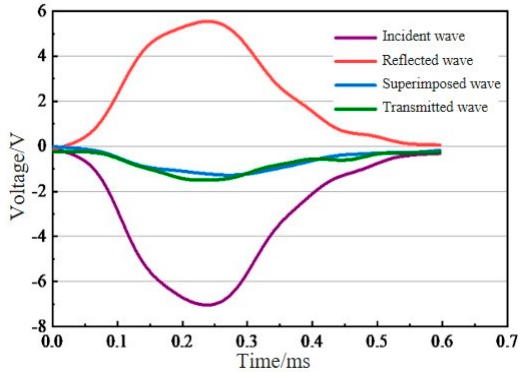
Figure 6. Typical waveform diagram after shaping.